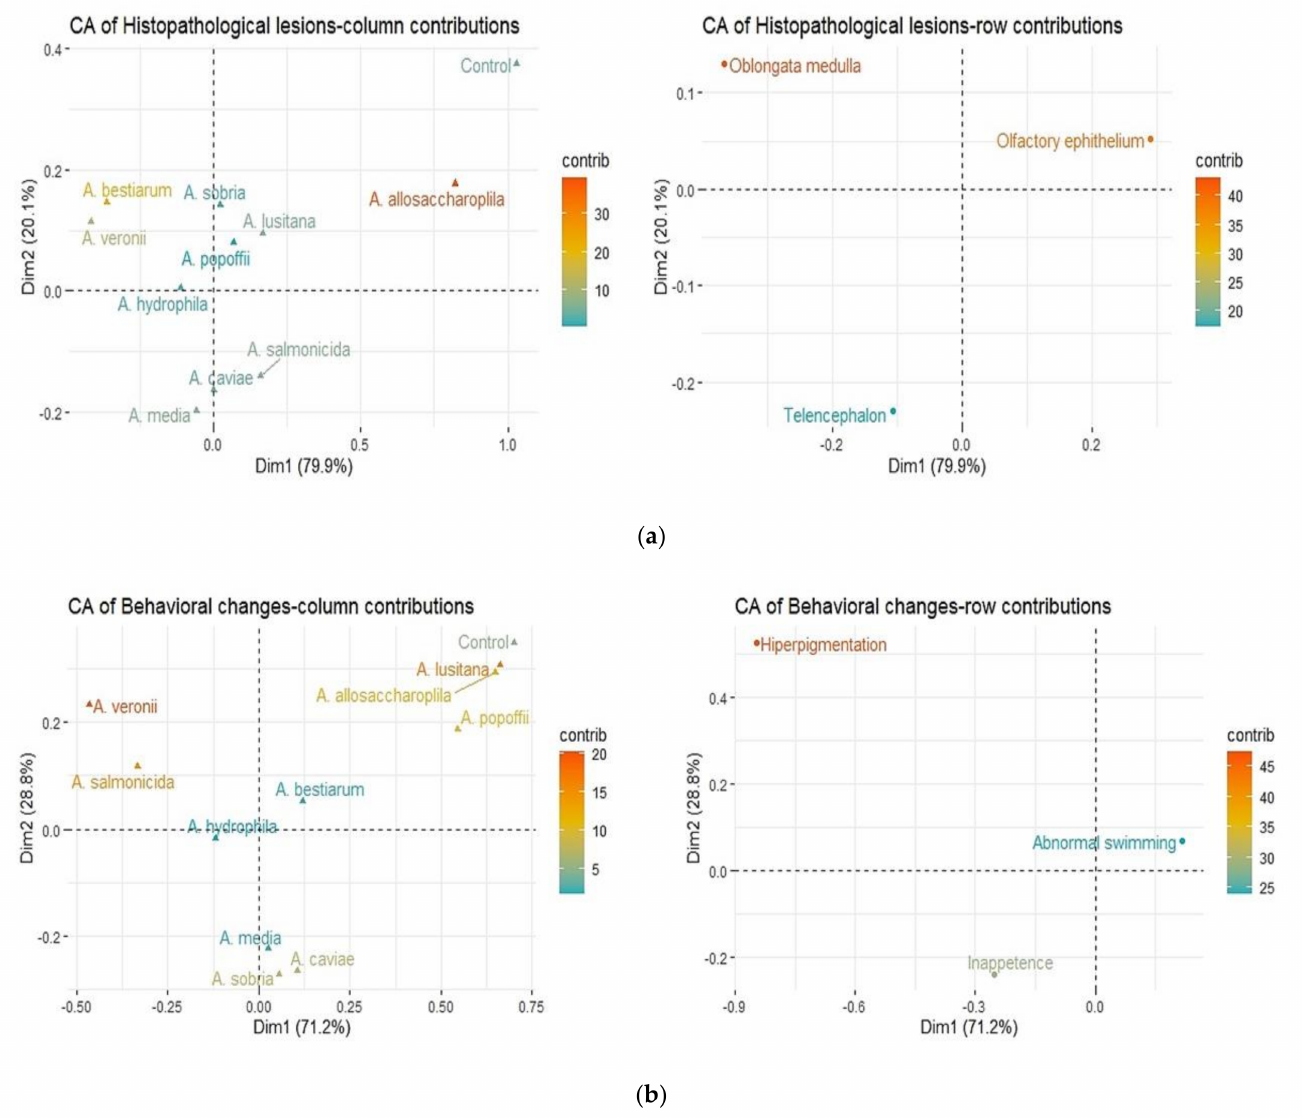
Figure 2. Correspondence analysis map. ( a ) Histopathological lesions and quality of representation to row and columns of dimen-sion 1; ( b ) behavioral changes and quality of representation to row and columns of dimension 1. The row and column categories are color coded according with the contribution to dimension